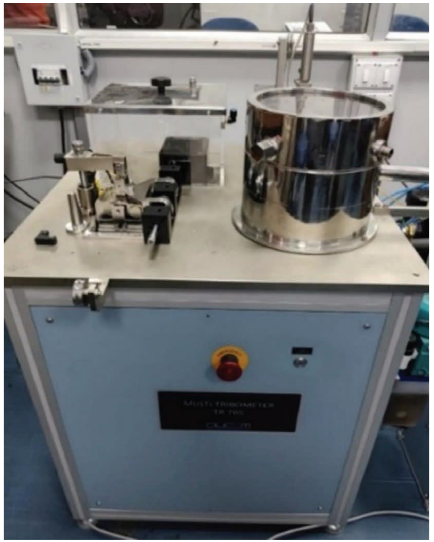
Figure 9: Prepared composite samples for impedance test char- acteristics estimation of: (a) single, double, and triple layers of silk fbres oriented in biaxial manner; (b) single, double, and triple layers of reinforced silk cloth composite samples.